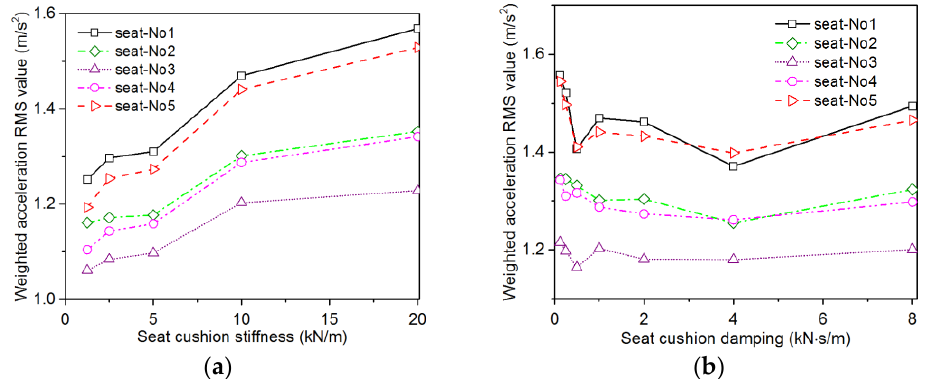
Figure 14. Effect of seat cushion parameters on ride comfort parameter N VA . ( a ) Stiffness effect; ( b ) damping effect.